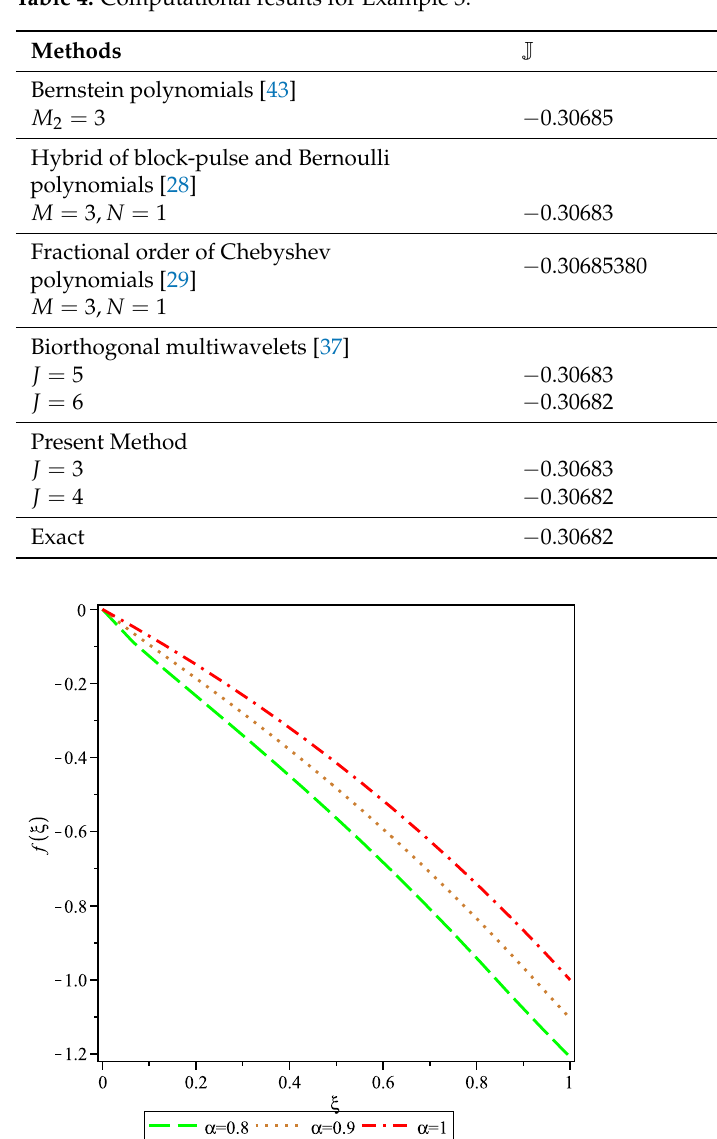
Table 4. Computational results for Example 3.